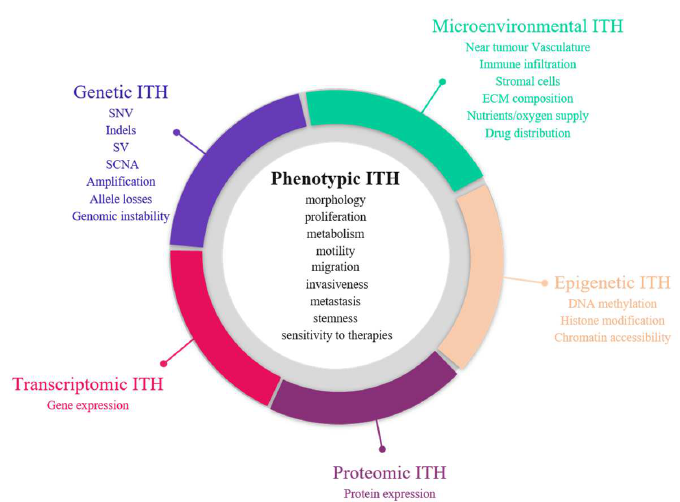
Figure 2. Sources of intra-tumour heterogeneity (ITH). Genetic, epigenetic, microenvironmental, transcriptomic and proteomic heterogeneities coexist in tumours and are linked with phenotypic diversity. Abbreviations: CAF: Cancer-associated fibroblasts; ECM: extracellular matrix; EMT: epithelial-to-mesenchymal transition; indels: small insertions and deletions; LOH: loss of heterozygoty;